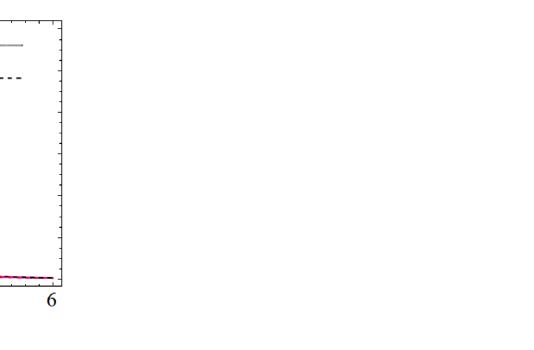
Figure 13. Under the influence of N t (thermophoresis parameter), θ(η) .